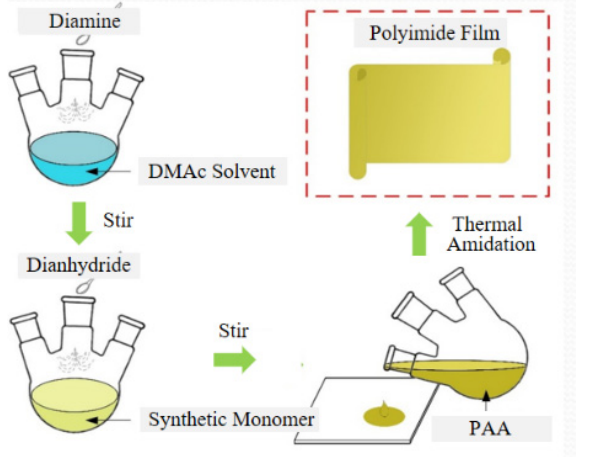
Figure 2. Process of film preparation. Table 1. Modification